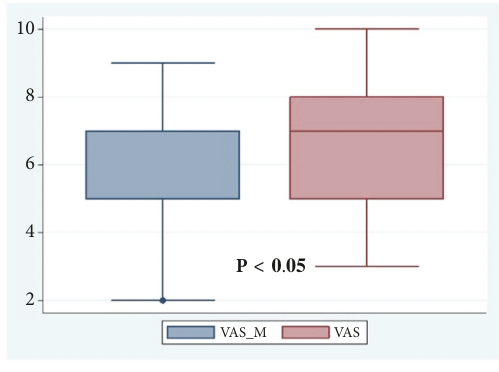
Figure 1: VAS of pain.